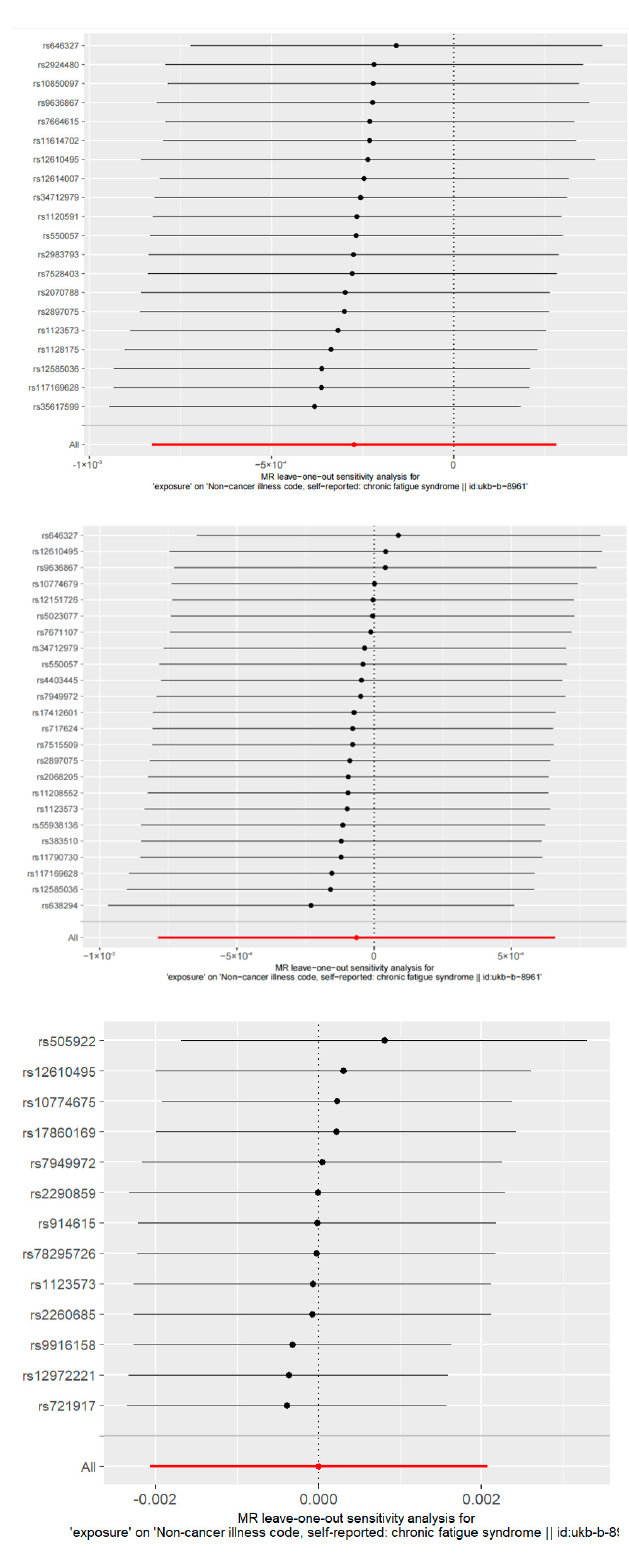
Figure 5. Sensitivity analysis results: “Leave-one-out”.